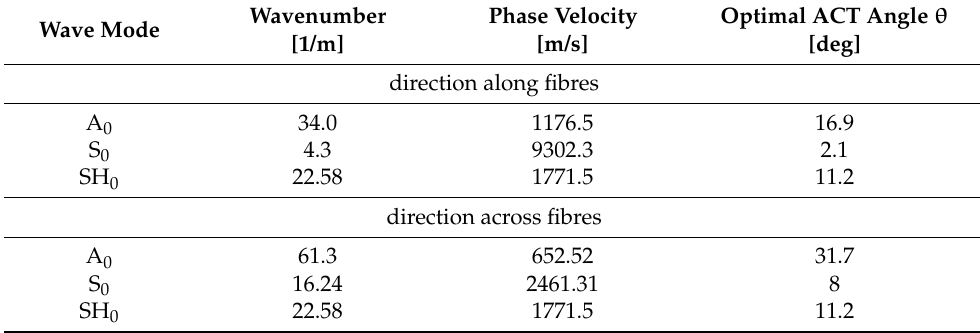
Table 1. Numerical results.